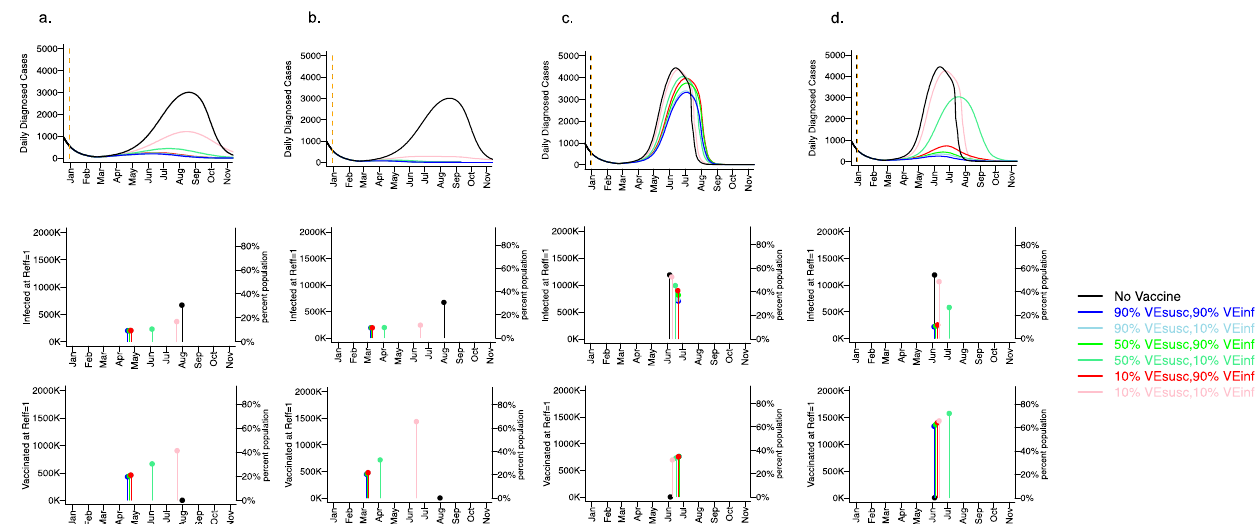
Figure 7. Rapid vaccine rollout rate and high VE SUSC or VE INF lower the number of infections prior Table 1. 1.7 variant. For unvaccinated (black lines) and each vaccine cohort (colored lines, legend), we project daily diagnosed cases during 2021 (top row); as well as timing of herd immunity threshold and number of infected at herd immunity threshold (middle row), and number of vaccinated at herd immunity threshold (bottom row) signified by dots and lines. Columns ( a , b ) assume the Wuhan variant while columns ( c , d )assume the 55% more infectious B.1.1.7 variant with 55% greater infectivity leading to more rapid accrual of cases. In ( a , c ), 5000 people are fully vaccinated per day starting 1 January 2021 (orange dotted vertical line) until 90% are vaccinated in age groups other than children. In ( b , d ), 10,000 people are fully vaccinated per day starting 1 January 2021 (orange dotted vertical line) until 90% are vaccinated in age groups other than children. VE SYMP is fixed at 90% in all simulations such that all vaccines would produce results consistent with those in the Pfizer and Moderna trials. High VE SUSC (90%) simulations are blue. Moderate VE SUSC (50%) simulations are green. Low VE SUSC (10%) simulations are red/pink. Dark lines are high VE INF (90%). Light lines are low VE INF (10%). The largest reduction in cases is associated with either high VE SUSC or VE INF . 80% of vaccines are initially allocated to the elderly. No reactive lockdown is assumed in these simulations such that herd immunity threshold is reached by virtue of cases and vaccinations.